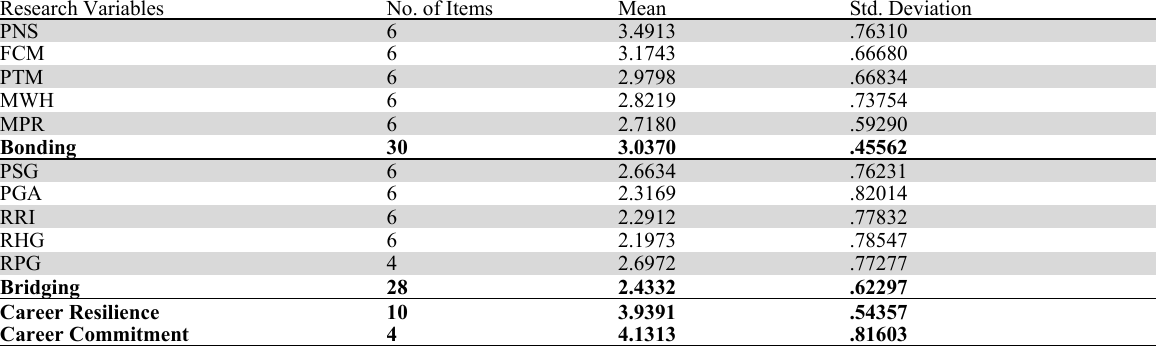
Descriptive Statistics for all Research Constructs of the Study Research Variables No. of